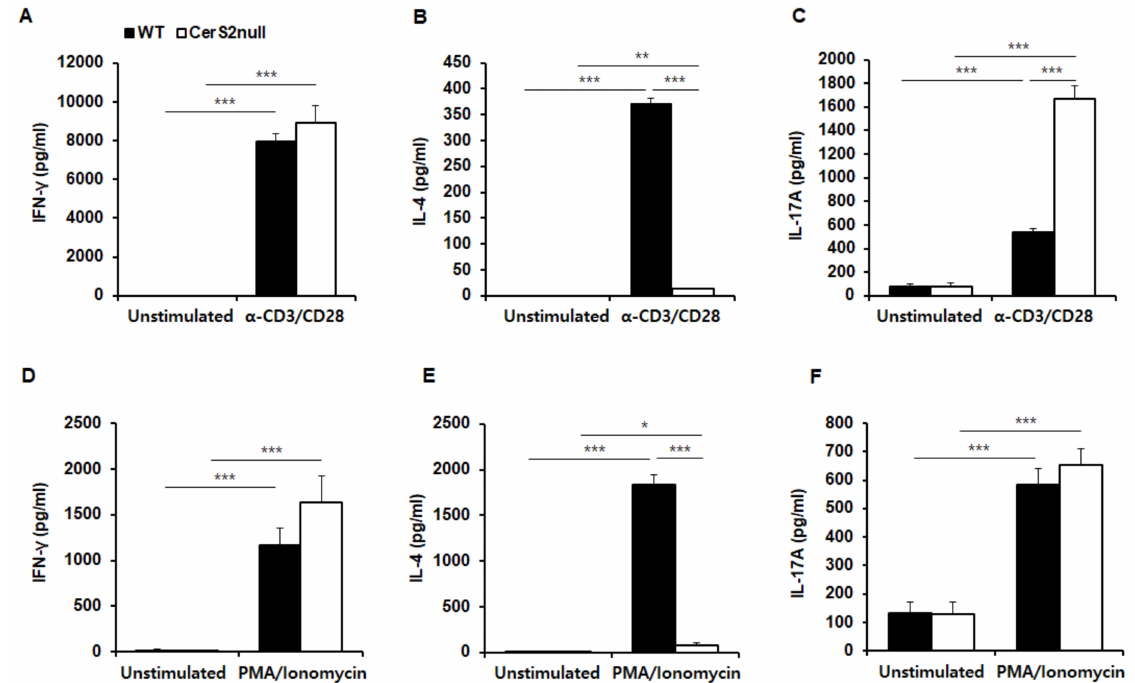
Figure 5. Wild type (WT)-CD4+ T and CerS2 null-CD4+ T cells are stimulated via a T cell receptor (TCR)-dependent or independent manner for cytokine production. Splenic CD4+ T cells from WT and CerS2 null mice were cultured in the presence or absence of anti-CD3/anti-CD28 antibodies ( α -CD3/CD28) for 3 days, followed by ELISA to measure secreted levels of ( A ) IFN- γ , ( B ) IL-4, and ( C ) IL-17. For T cell receptor-independent stimulation, splenic CD4+ T cells from WT and CerS2 null mice were cultured in the presence or absence of phorbol 12-myristate 13-acetate (PMA)/ionomycin for 16 h, and the secreted ( D ) IFN- γ , ( E ) IL-4, and ( F ) IL-17 were measured by ELISAs. Data are expressed as the mean ± SEM ( n = 4). * p < 0.05; ** p < 0.01; *** p < 0.001. Statistical significance was analyzed using the two-way analysis of